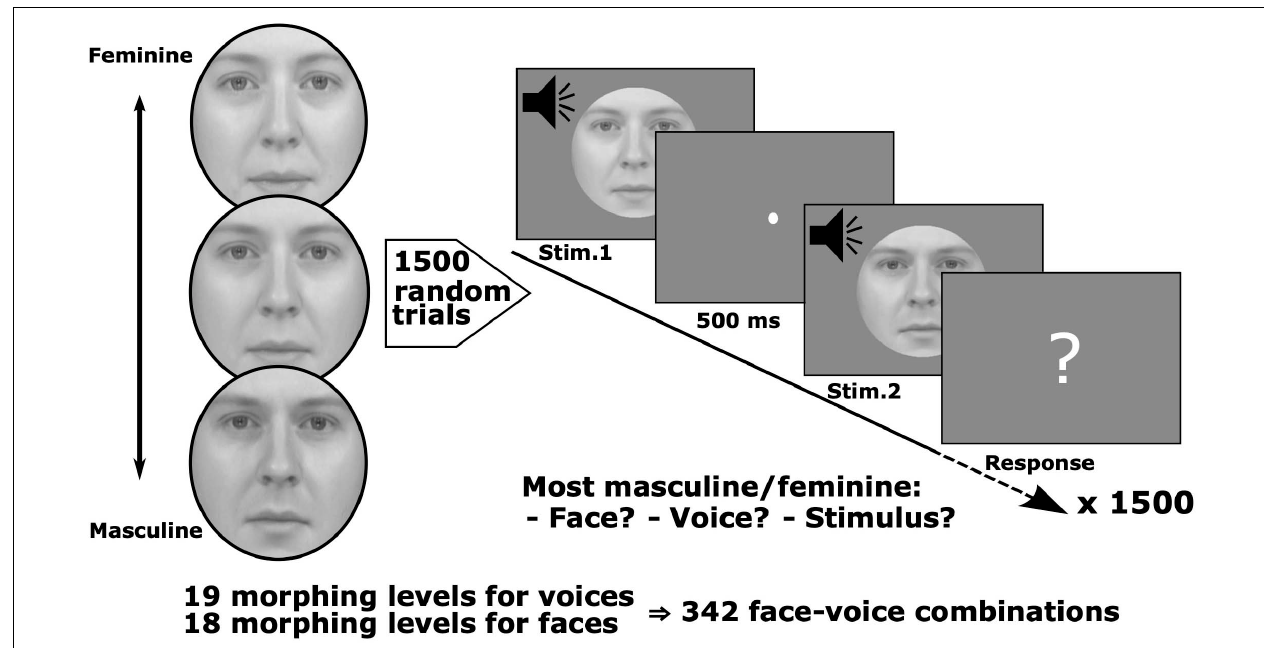
FIGURE 1 | Stimulus set and conjoint measurement protocol. Pairs of face-voice video sequences with independently varying levels of face and voice gender morphing were judged by observers according to: (1) face gender, (2) voice gender, or (3) stimulus gender, i.e., taking both face and voice into account. Stimulus pairs were sampled from a set with 18 levels of morphing for the face and 19 levels for the voice. Six groups of observers judged which face, voice or stimulus was either more masculine or feminine (6 observers/group, each group balanced with respect to gender, 36 observers total, and 1,500 trials/observer).